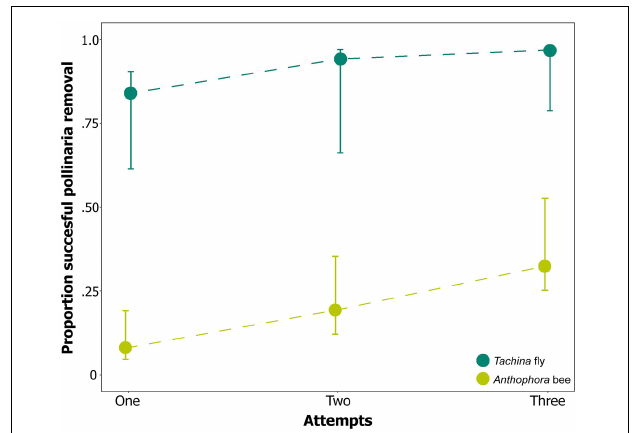
FIGURE 9 | Pollinaria removal success in up to three attempts by the two main pollinator guilds of Neotinea ustulata , bees ( Anthophora plumipes ; n = 12) and flies ( Tachina fera ; n = 6). Back-transformed means and standard errors are shown.